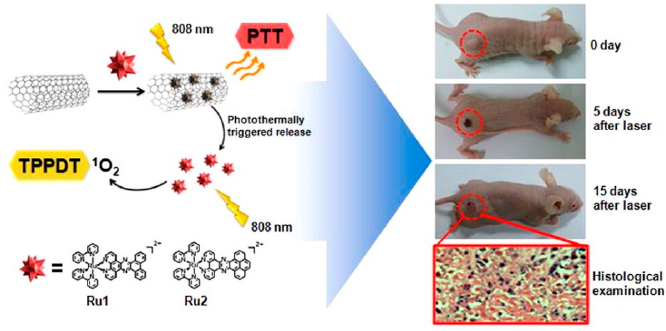
Figure 5. Schematic representation of Ru@SWCNTs for Bimodal PTT and Two-Photon Photodynamic Therapy (TPPDT) using irradiation at 808 nm. Image adapted with permission from [119].